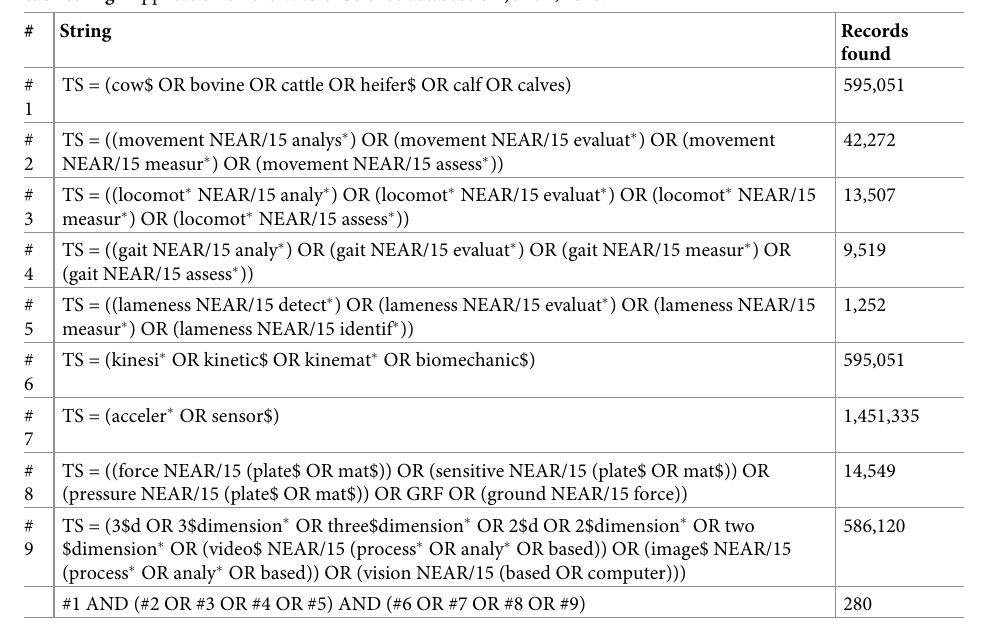
Table 1. List of the different strings included in the search strategy and the number of retrieved references for each string. Application on the Web of Science database on June 2,